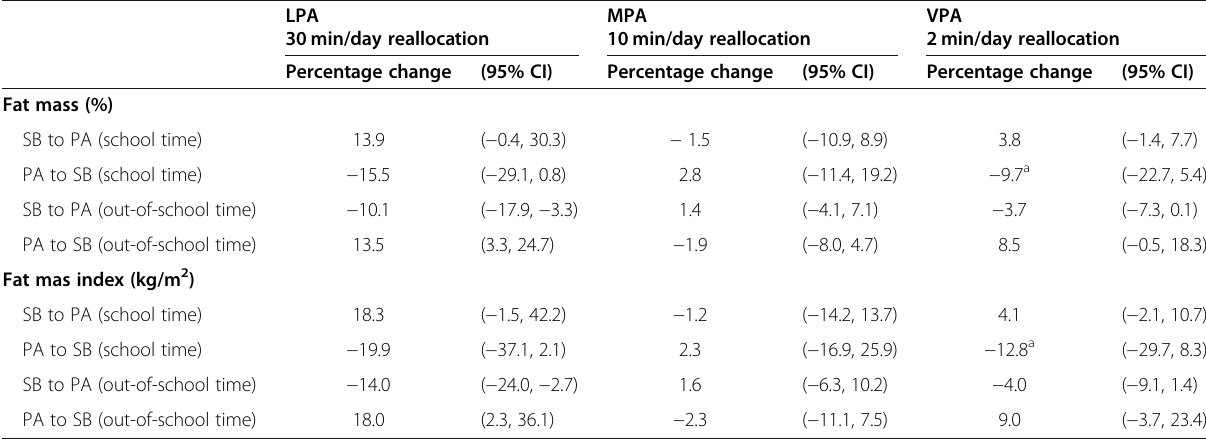
Table 4 Estimated relative difference in adiposity associated with replacing context-specific sedentary behaviors with physical activity among girls ( n = 208) LPA 30 min/day